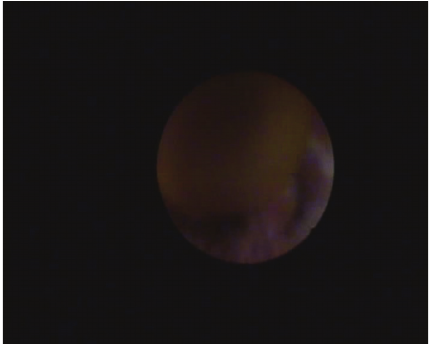
Figure 2: Stone in prostate